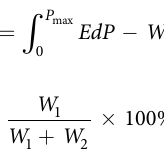
where E is the applied electric field and P is polarization, whereas P max is the maximum polarization with respect to the maximum experimental electric field. W 2 is the energy loss density caused by the domain reorientation. In general, the energy densities can be obtained from P-E hysteresis loops. W 1 can be evaluated by integrating the area between the polarization axis and the discharge curve, and W 2 is obtained by integrating the area between the charge and discharge curve. Schematic diagram for the calculation of energy storage properties based on the P-E loop of the (1-x)LLBNTZ-xNBN ceramics is shown in Fig. S5. The energy storage efficiency is the ratio of discharge energy density to charge energy density and the area of the loop represents the energy loss density. Calculated energy storage density, energy loss density and energy storage efficiency as a function of electric field